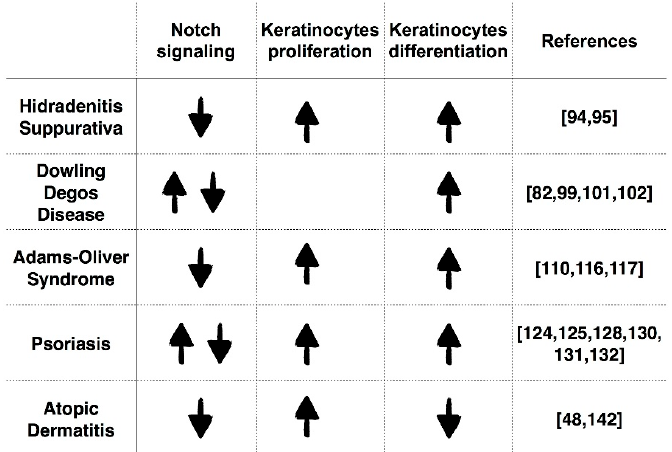
Figure 10. Schematic representation of the interactions between Notch signaling, proliferation and differentiation of keratinocytes in skin diseases. The role of Notch signaling, proliferation and differentiation of keratinocytes in Hidradenitis Suppurativa, Dowling Degos Disease, Adams–Oliver Syndrome, Psoriasis and Atopic Dermatitis. The arrows facing upwards ( ↑ ) indicate an upregulation, while the arrows facing downwards ( ↓ ) designate a downregulation, of Notch signaling, keratinocyte proliferation and differentiation in the various skin diseases.